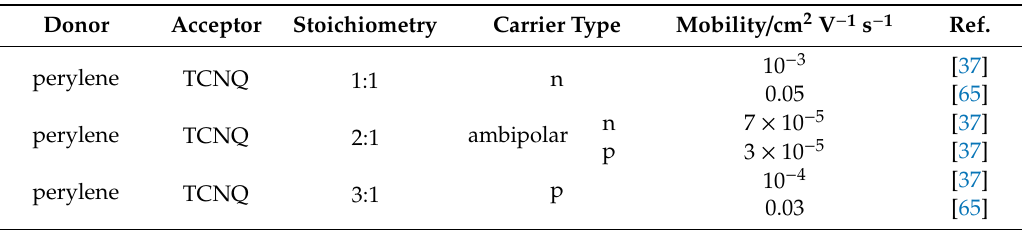
Table 4. Performance of single-crystal field-effect transistors based on (perylene) 1 -(TCNQ) 1 , (perylene) 2 - (TCNQ) 1 and (perylene) 3 -(TCNQ) 1